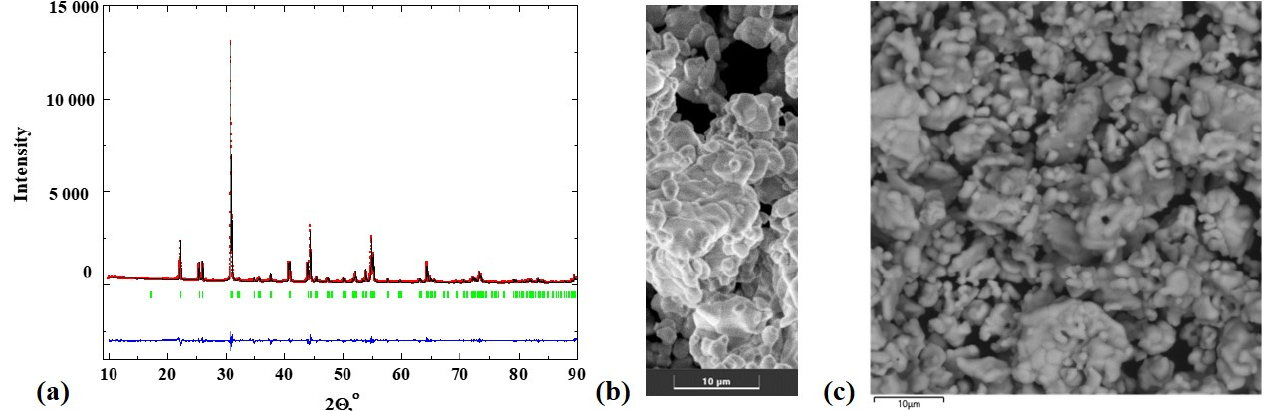
Figure 1. The XRD-patterns ( a ) (R p = 1.99, R wp = 2.03, χ 2 = 1.09) and SEM-image ( b , c ) of powder sample SrLa 2 Sc 2 O 7. Table 1. The lattice parameters and unit cell volumes of the compositions SrLa 2 Sc 2 O 7 and BaLa 2 In 2 O 7 .